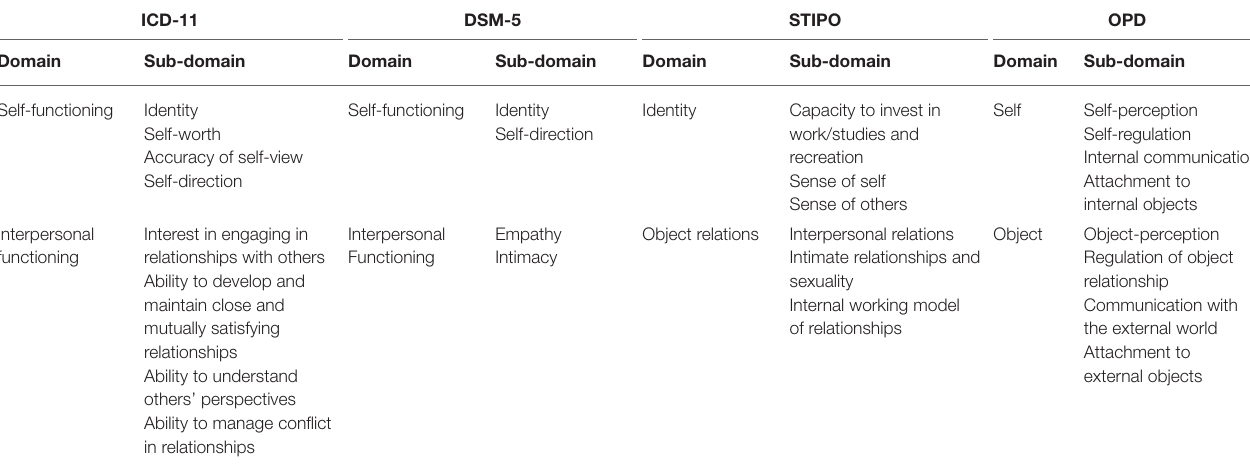
TABLE 1 | Domains of self- and interpersonal functioning in ICD-11, DSM-5, object relations theory (STIPO) and